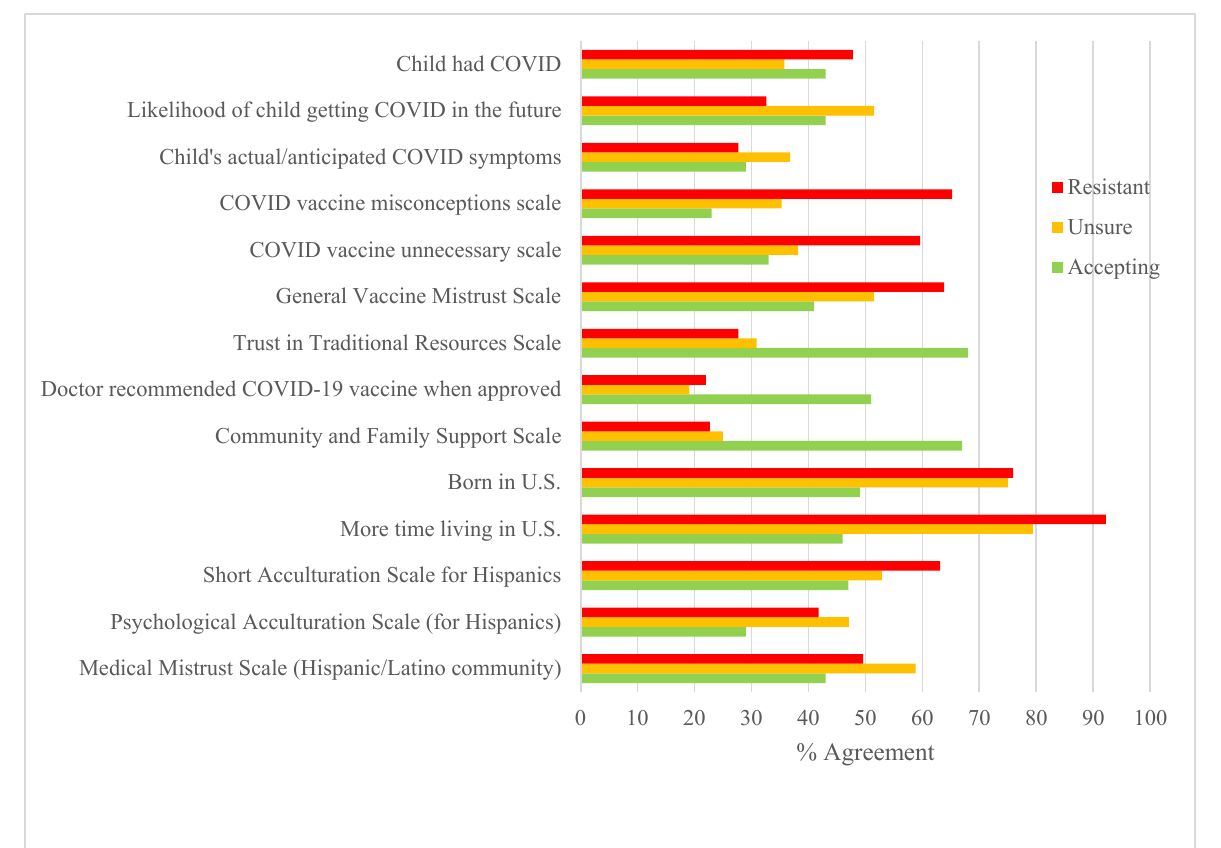
Figure 2. Percent of resistant, unsure, and accepting parents reporting agreement with health beliefs, physician and community support, cultural factors and medical mistrust. Note: For Figure 2, continuous scales were recoded into dichotomous variables using median split, with the percentages in the graph reflecting agreement (scores above the median). Likelihood of getting COVID-19 illustrates the percentage of parents reporting that it was likely or very likely that their child would contract COVID-19. Child’s actual/anticipated COVID-19 symptoms illustrates the percent of parents reporting their child had/would have moderate or severe COVID-19 symptoms. More time living in the U.S. illustrates parents who had been in the US 5 years or more.